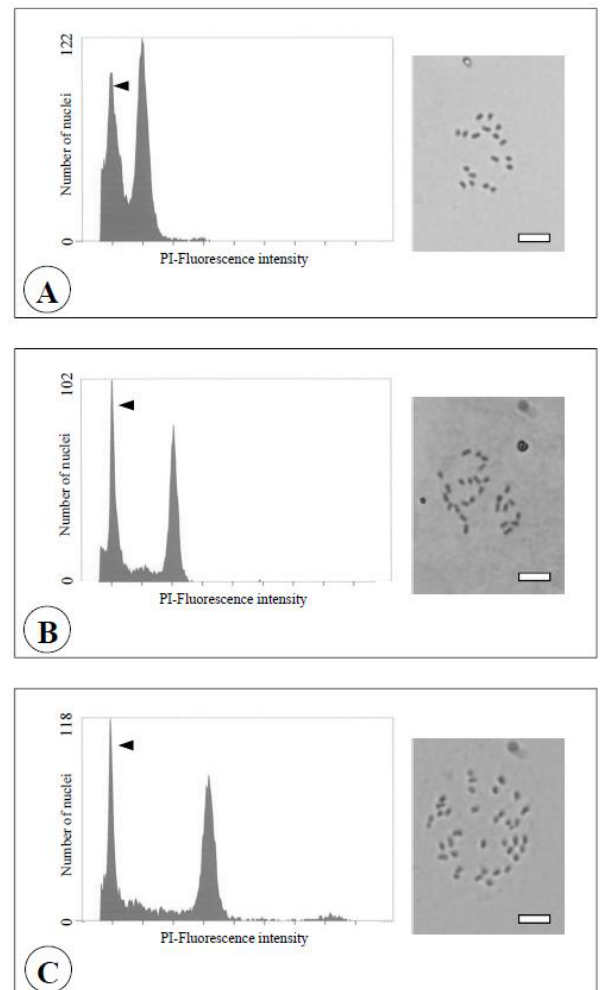
Figure 7. Flow cytometric analysis (left) and chromosome observation (right) of the seedlings obtained from reciprocal crosses between the diploid and the chimera of the Meiwa kumquat. Bars = 10 μm. A : Diploid (2n = 2x = 18). B : Triploid (2n = 3x = 27). C : Tetraploid (2n = 4x = 36). Arrows indicate the relative fluorescence of internal standard (the haploid pummelo (2n = x = 9, Yahata et al., [19])).